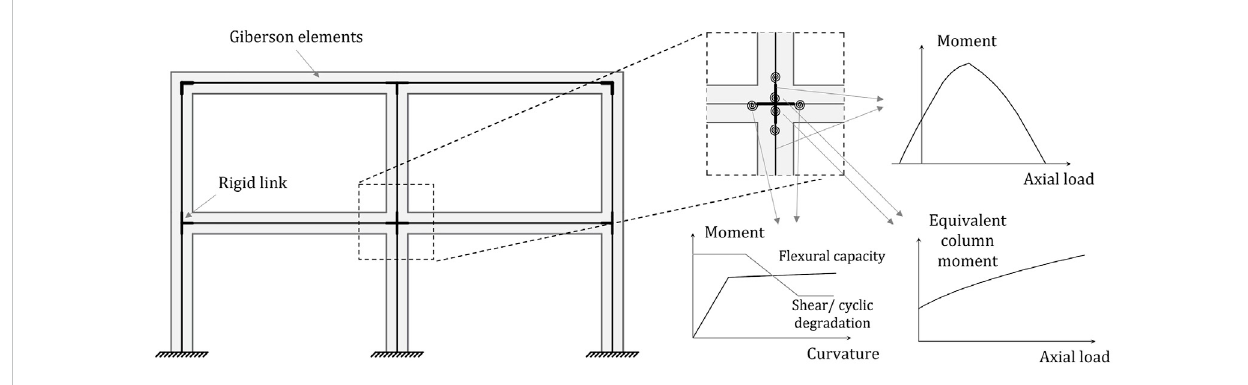
FIGURE 8 Adopted modeling strategy (modi fi ed after Gentile et al.,